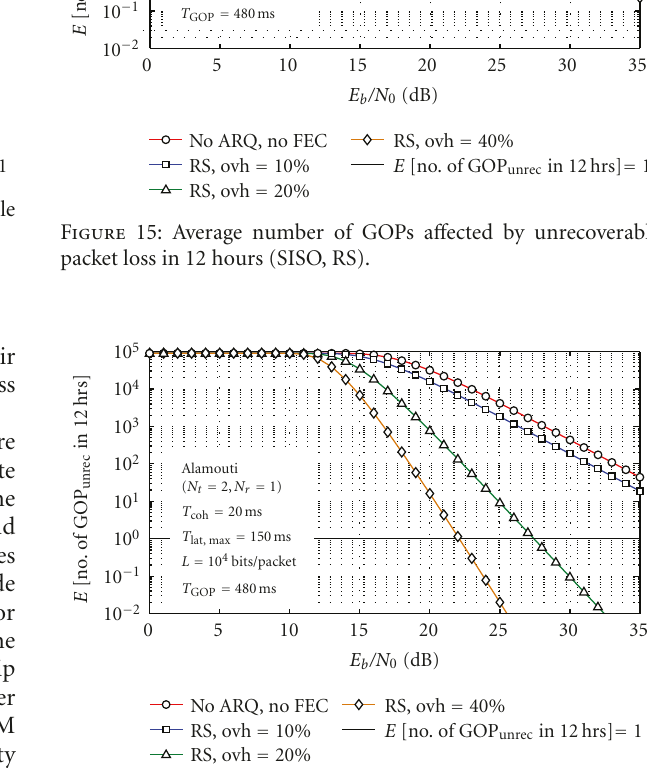
Figure 16: Average number of GOPs a ff ected by unrecoverable packet loss in 12 hours (Alamouti, N r = 1,